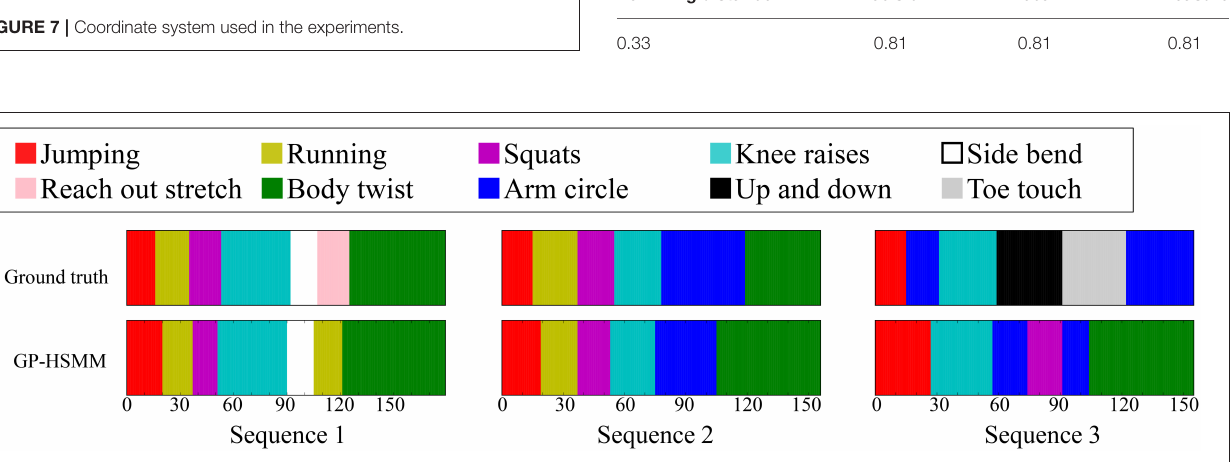
FIGURE 8 | Segmentation results of CMU motion capture